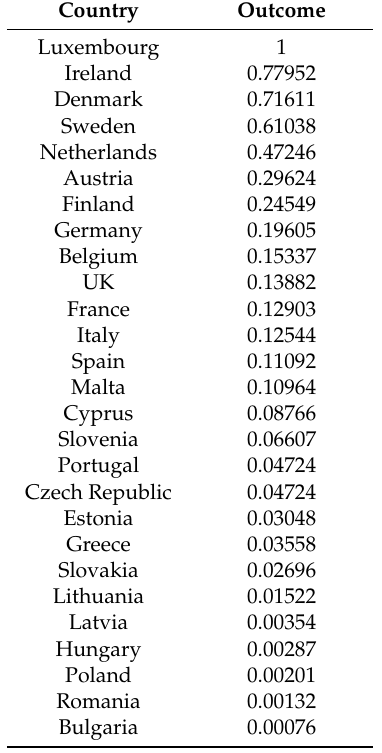
Table 5. Ranking of the countries after applying the